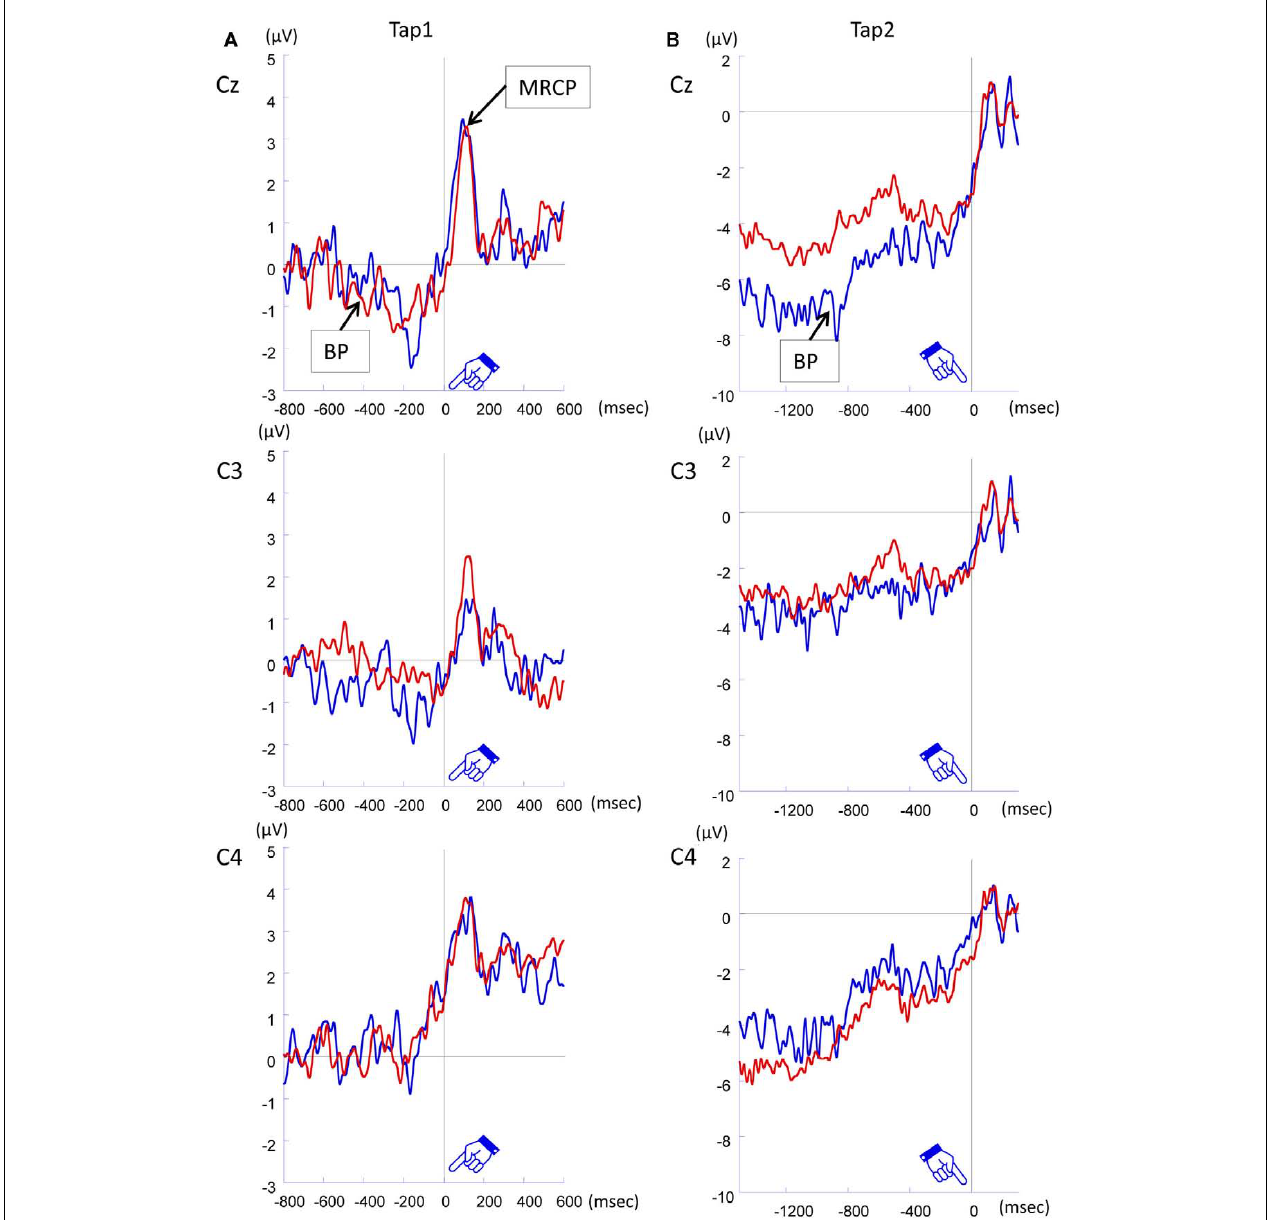
FIGURE 7 | Grand averaged ERP waveforms time-locked toTap1 (800ms condition with-sounds) (A), and (B) time-locked toTap2 (800ms condition with-sounds)